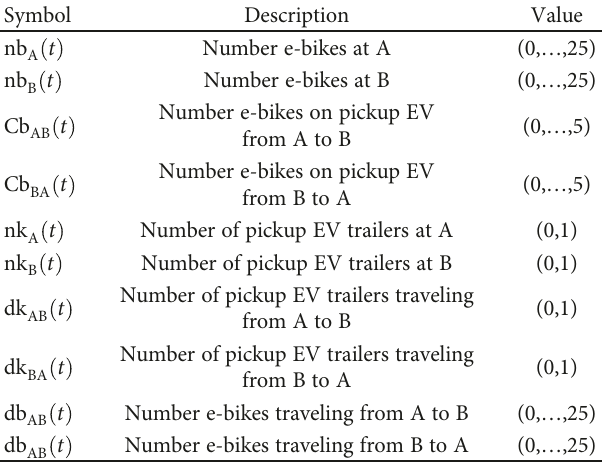
Table 6: Integer variables of the optimization